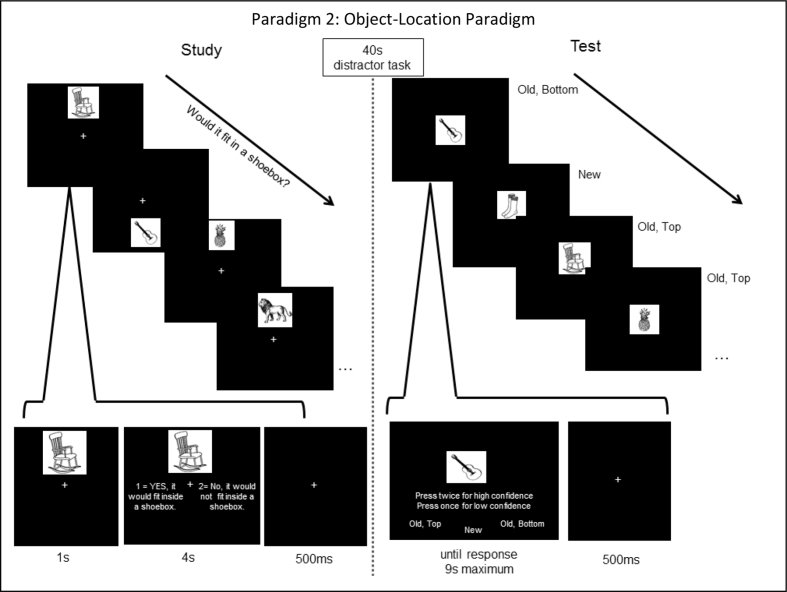
Paradigm 2: Object Location Paradigm. This was a study-test blocked source monitoring paradigm, in which items were studied at top or bottom locations while making “yes”/”no” judgement as to whether they would fit in a shoebox. A 40 s (sec) distractor task of counting backwards occurred between study and test blocks. In test blocks, participants reported whether items were “new” or had appeared in “top” or “bottom” locations, pressing the response key twice if highly confident.